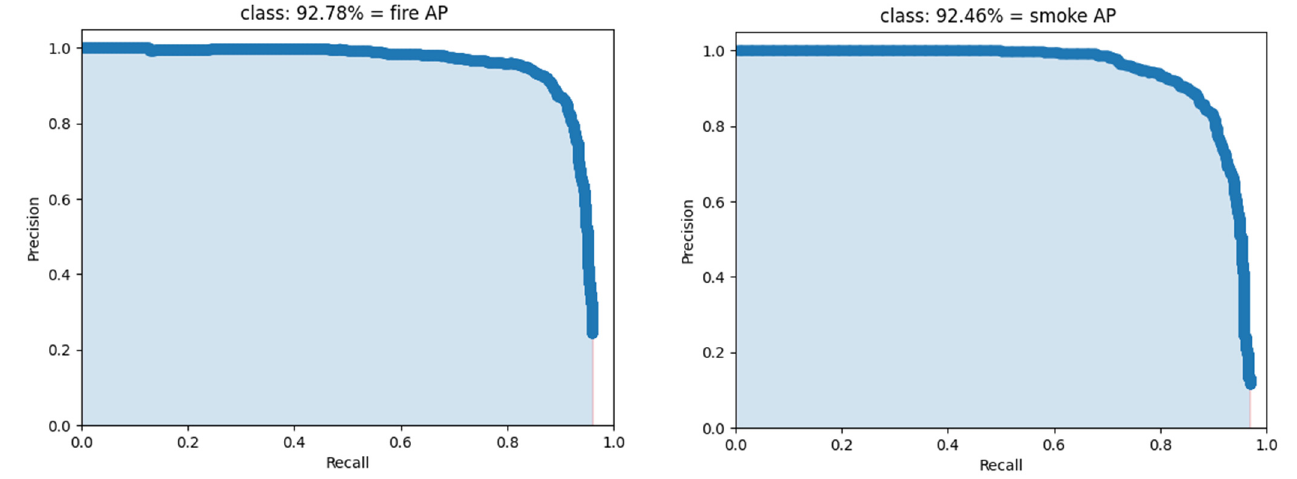
Figure 12. PR curves of different models.